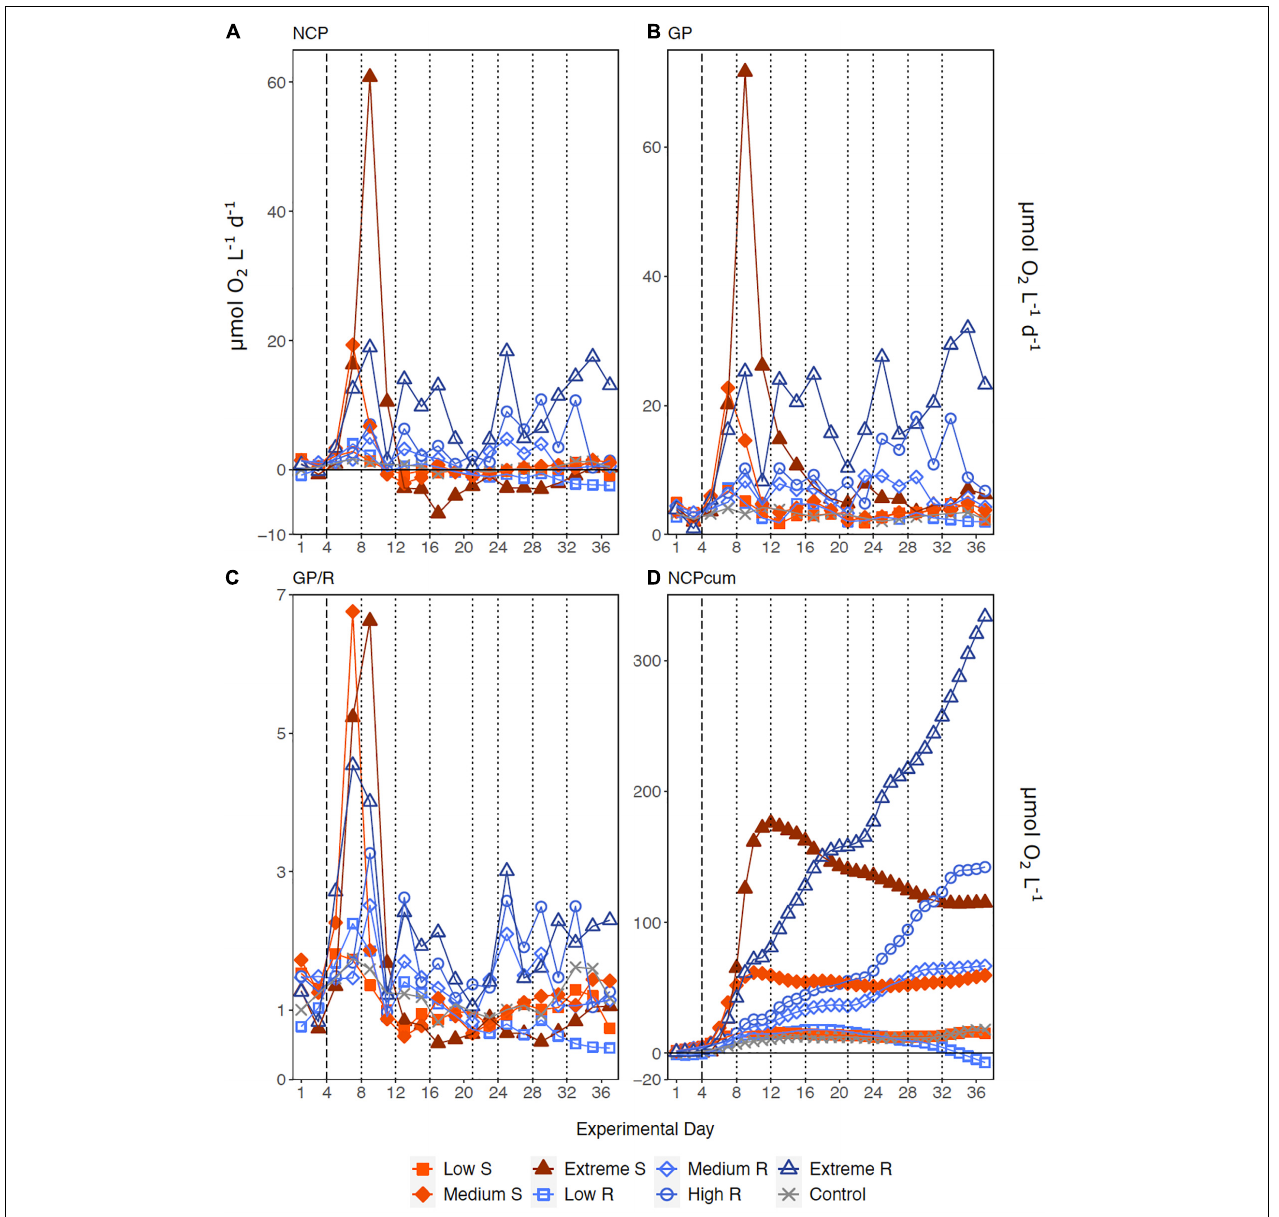
FIGURE 2 | Temporal development of (A) Net Community Production, (B) Gross Production, (C) the ratio of GP to respiration (GP/R) and (D) accumulated NCP. Dotted lines represent DW additions, dashed line marks the single DW addition to singular treatments. S, singular; R, recurring